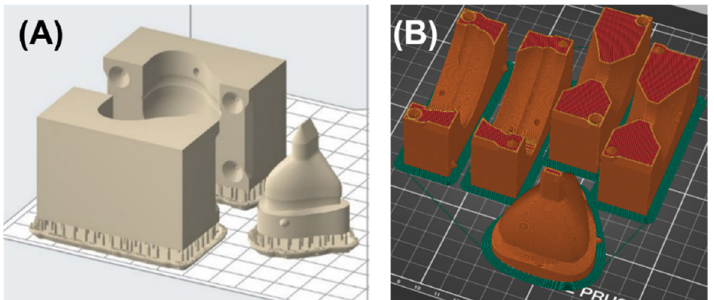
Figure 7. Orientation and position of the molding form on a building platform for nasal and oronasal mask. ( A ) Placement of molding parts as well as supporting structures for the nasal mask on the building platform in PreForm Version 3.12.2 (Formlabs, Sommerville, MA, USA); ( B ) Oronasal mask molding form parts on the building platform in PrusaSlicer Version 2.3.0 (Prusa Research a.s., Praha, Czech Republic).